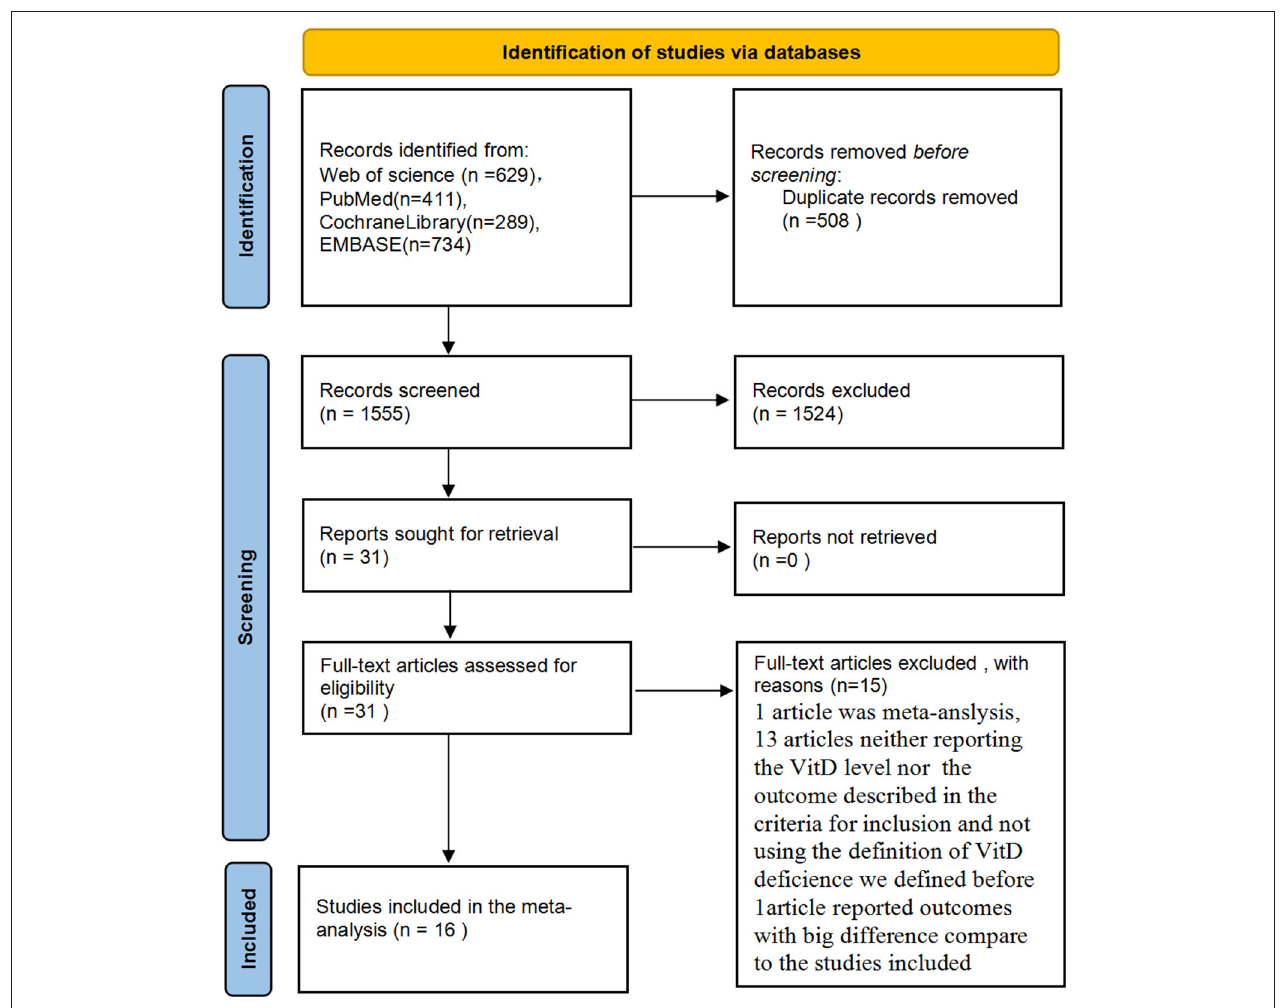
FIGURE 1 | Preferred reporting items for systematic reviews and meta-analyses (PRISMA) flow diagram for study identification and selection.